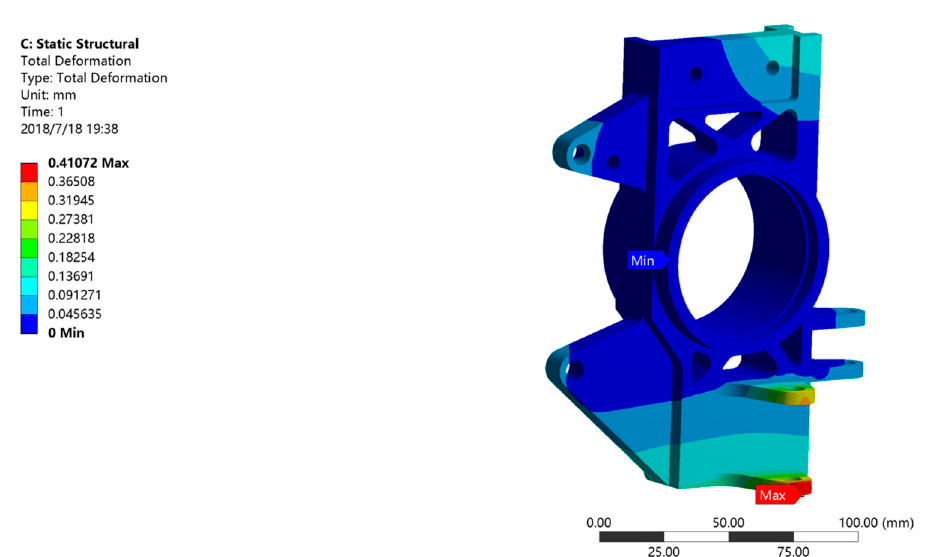
Figure 9. Stress cloud. Figure 9. Stress contour.